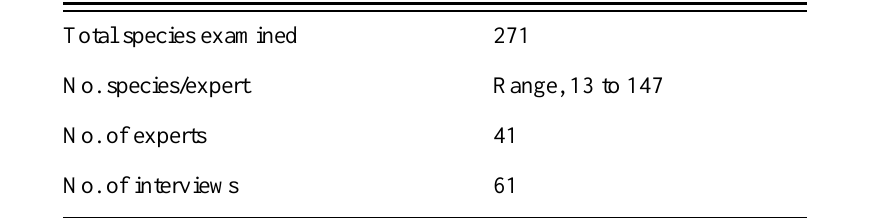
Table 2 . Summary of interview data and species